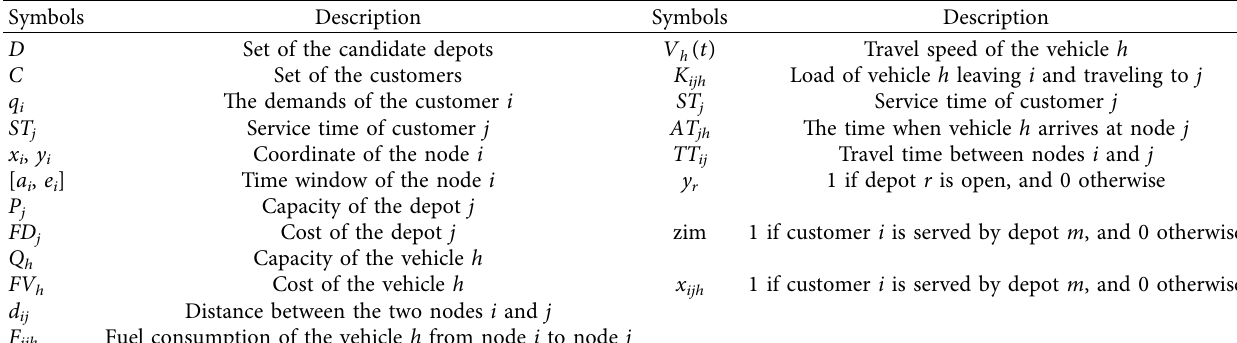
Table 2: Parameters and